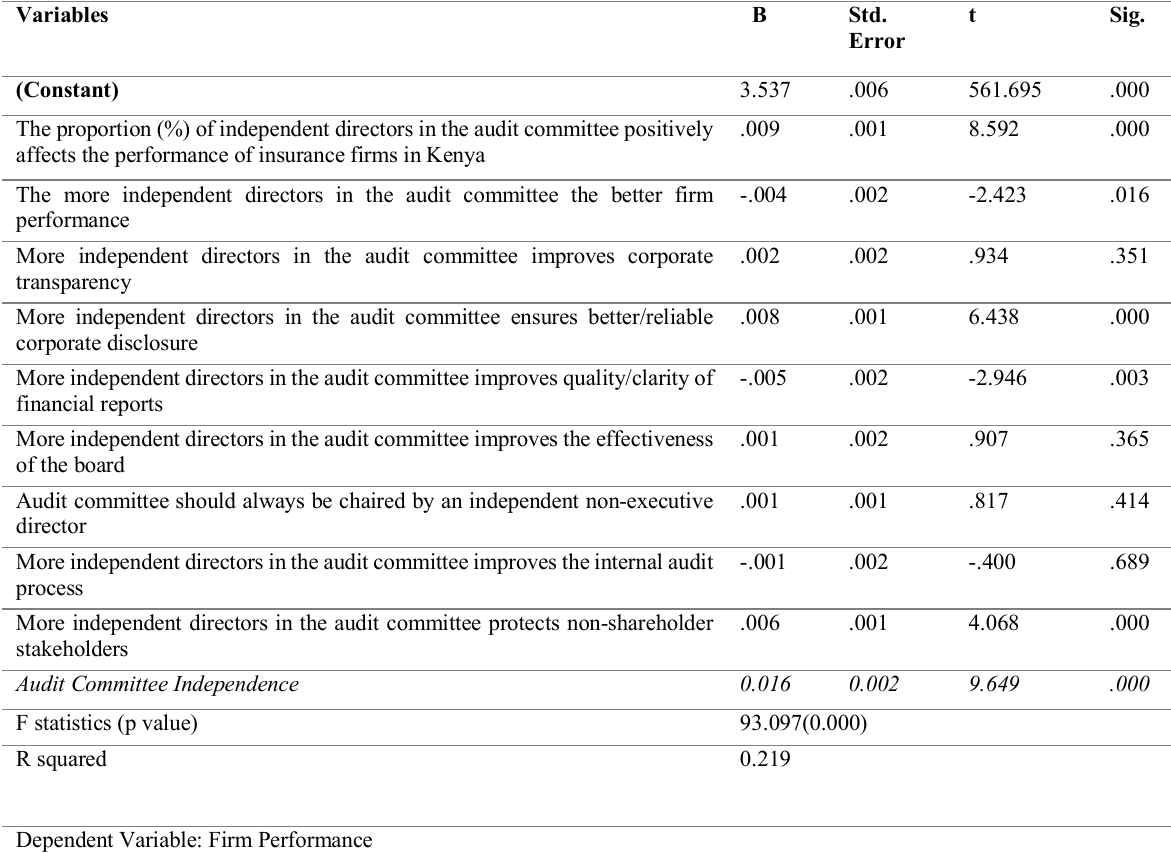
Table 10: Regression Analysis for Audit Committee